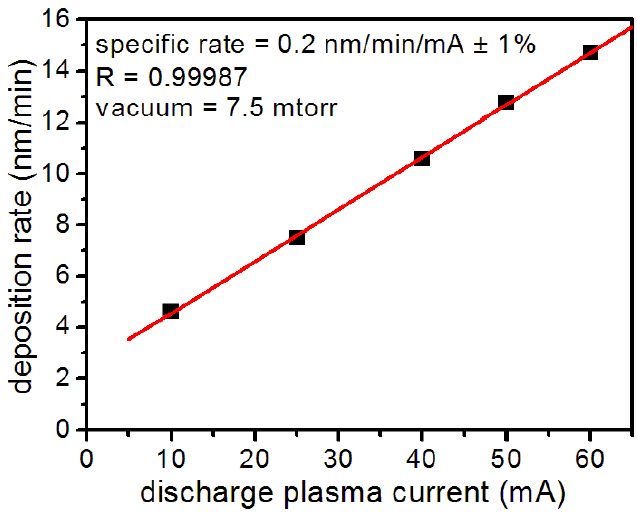
Figure 2. Sputtered gold deposition rate vs. plasma discharge currents holding the vacuum pressure at 7.5 mTorr during metal deposition. The deposition rate is linear in the discharge current with a correlation coefficient R =